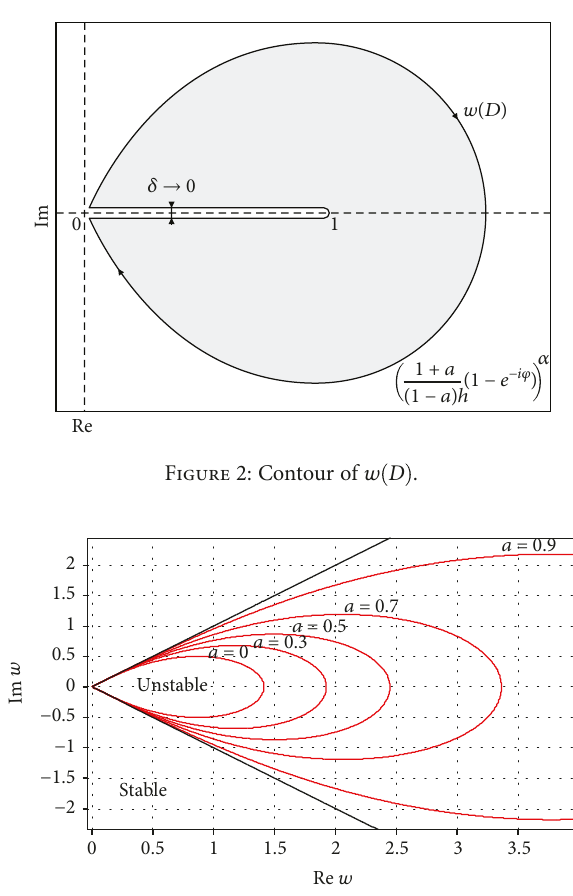
Figure 3: Stability/instability areas for h = 1 and various a .